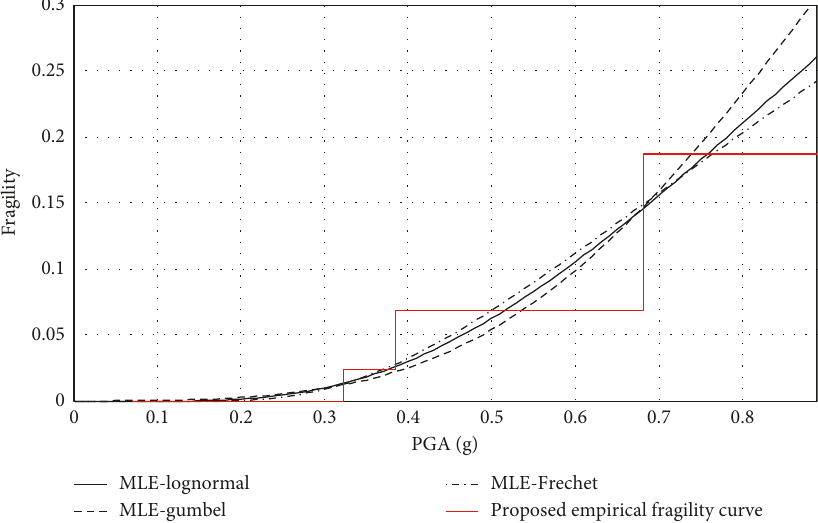
Figure 9: Comparison of empirical fragility curves of damage state with